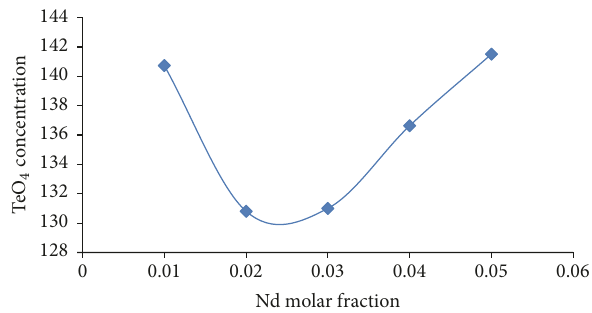
Figure 3: TeO 4 concentration of [(TeO 2 ) 0.70 (ZnO) 0.30 ] (1−𝑥) (Nd 2 O 3 NPs) (𝑥)